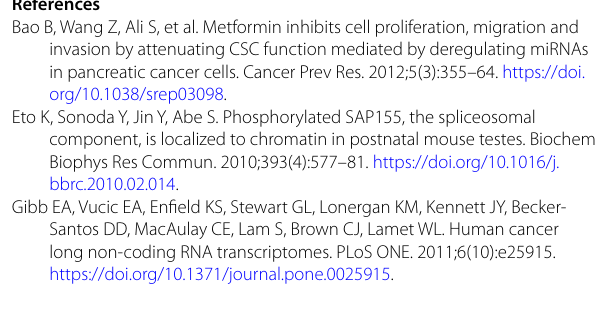
Additional file 1: Table S1. Primer sequences used in this study. Table S2. Clinical characteristics of 6 patients with PDAC for microar- ray. Table S3. 128 differentially expressed lncRNAs ( between six PDAC samples and paired nontumor samples. Table S4.